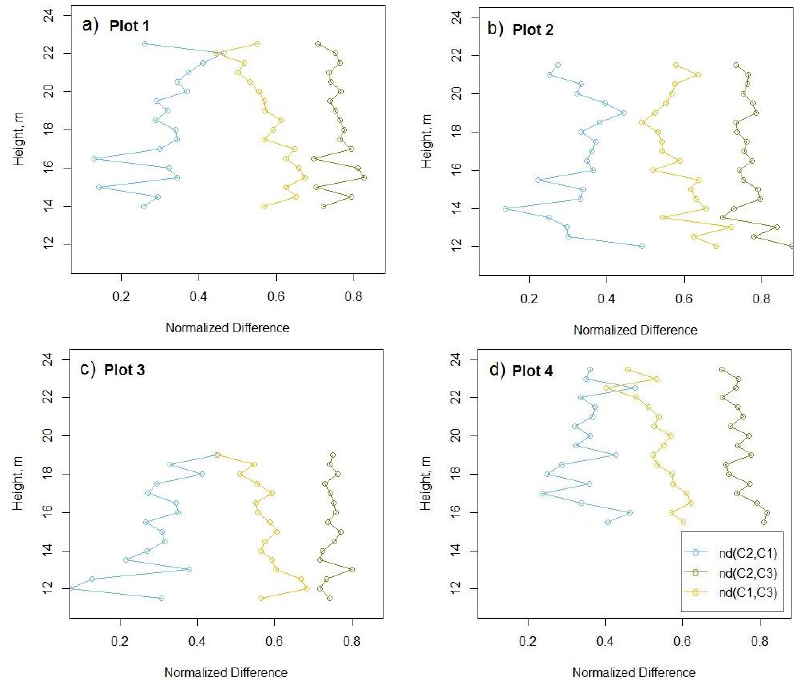
Figure 8. LP plot-level canopy vertical spectral vegetation indices (SVIs) derived from spectral pseudo-reflectance values for plots in Figure 2b. ( a ) Plot 1; ( b ) Plot 2; ( c ) Plot 3; ( d ) Plot 4.